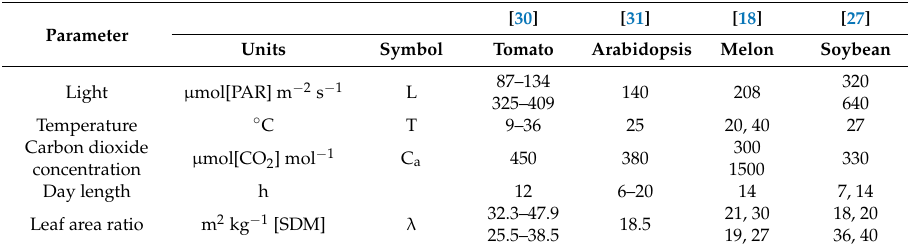
Table 3. Environmental conditions used to simulate growth and non-structural carbohydrate in various